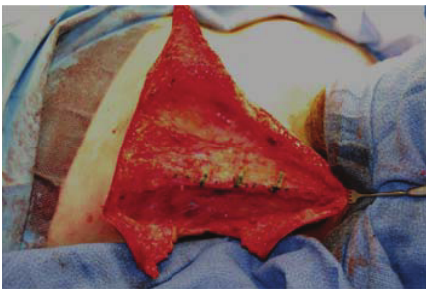
Figure 3: A lateral approach allows for complete visualization of fibrotic fascial band on the trapezius muscle. Markings indicate regions to be resected.